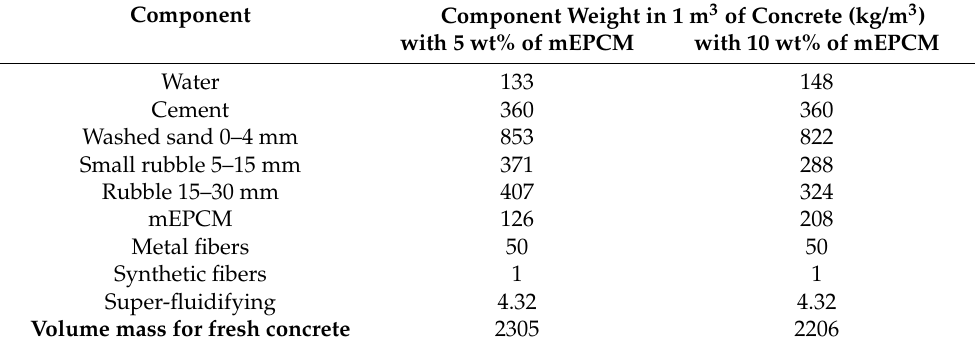
Table 4. Concrete/mEPCM mix